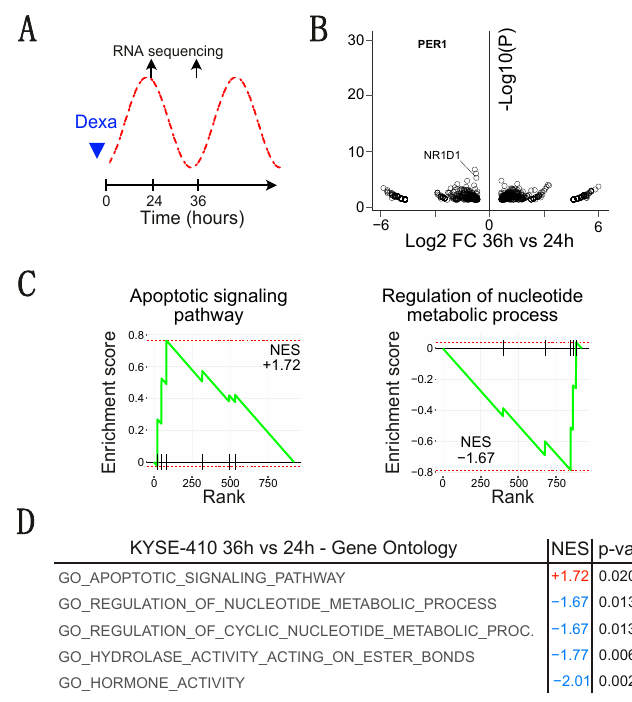
Figure 3. PER2 expression oscillations are associated to modifications of the transcriptome. ( A ) Experimental design. ( B ) Volcano plots representing results of RNA-seq as the statistical significance versus the magnitude of fold of change (FC) in KYSE-410 compared to control esophageal cells. Data are filtered based on FC (abs(LFC) > 1) and p -value ( p < 0.05). ( C ) Gene set enrichment analysis (GSEA) of the significantly modified transcripts in KYSE-410 cells compared to control esophageal cells (abs(LFC) > 1, p -value < 0.05). ( D ) Table summarizing the results of the GSEA. Pathways with a p -value < 0.05 are listed and sorted based on normalized enrichment score.